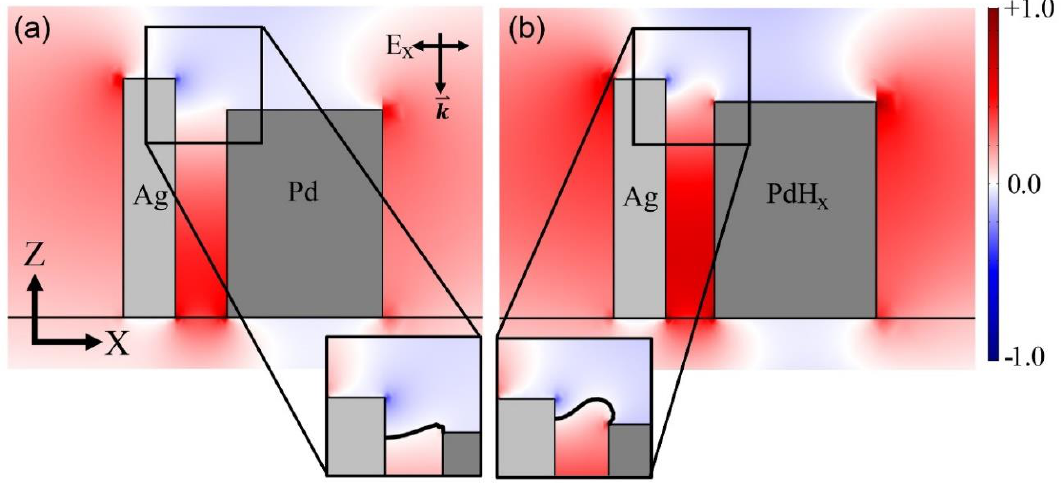
Figure 2. E x field profiles of sensors composed of Ag and Pd nano-blocks for incident light with a wavelength of 1000 nm ( a ) before and ( b ) after hydrogen absorption. ( b ) Pd lattice expansion of 3.57%; the change in the optical constant was investigated for a hydrogen concentration (H / Pd) of 0.82. Insets represent enlarged upper ends of the two blocks. Solid lines in the insets represent the boundary at which the E x field is zero.